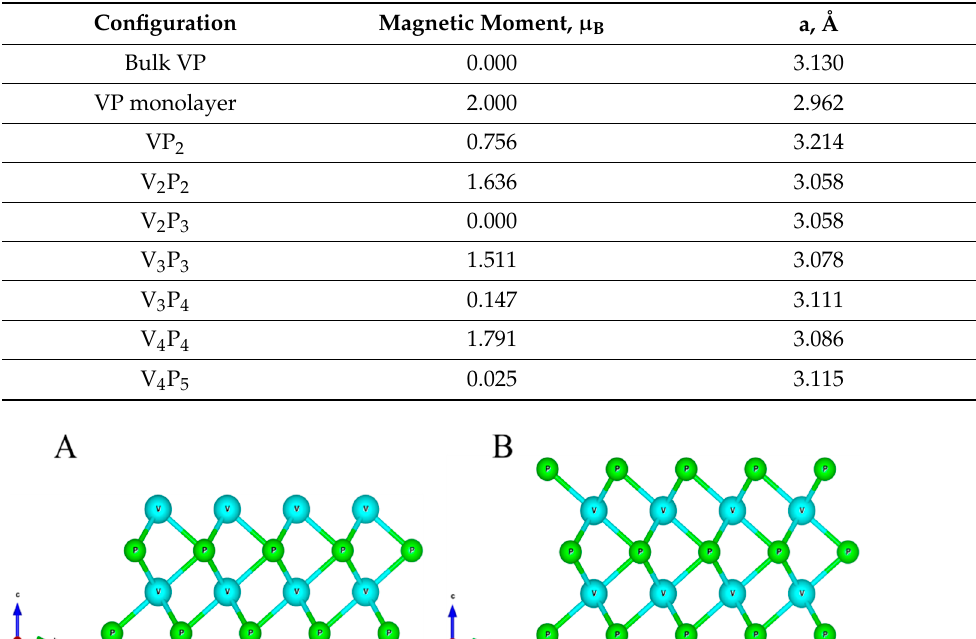
Table 1. Lattice parameter a, magnetic moment and stability of stoichiometric and non-stoichiometric configurations of VP from one to four layers. Configuration